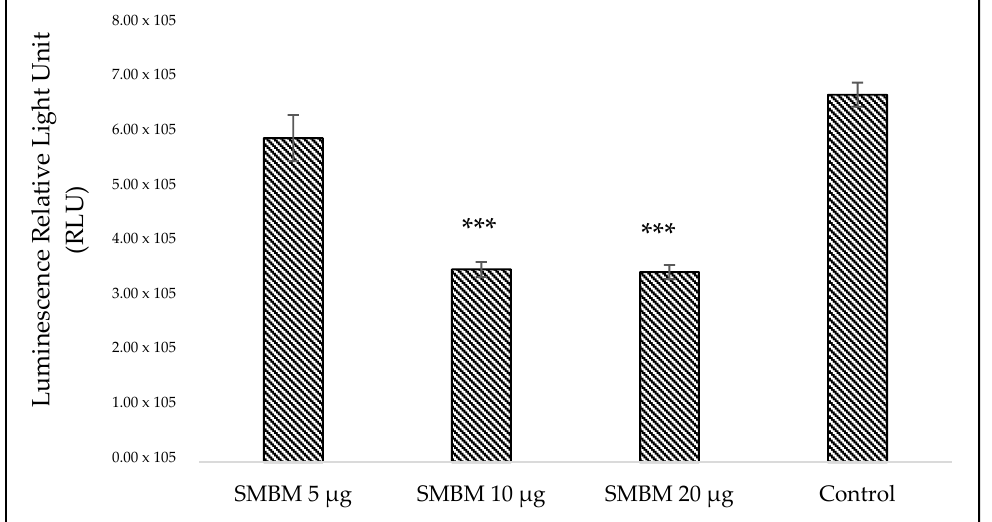
Figure 2. Adenosine triphosphate (ATP) metabolism in MCF-7 cells treated with SMBM. The higher ATP levels in the control group signify healthy and proliferating cells. However, the groups treated with different doses of SMBM extract show decreased ATP levels, which propose the antiproliferative nature of SMBM to MCF-7 cells. The doses at 10 and 20 μ g showed almost similar toxic effects on MCF-7 cells. The data represent the mean ± SEM. Significantly different at *** p < 0.001 when compared to the control. SMBM— S. mundagam bark methanol extract.